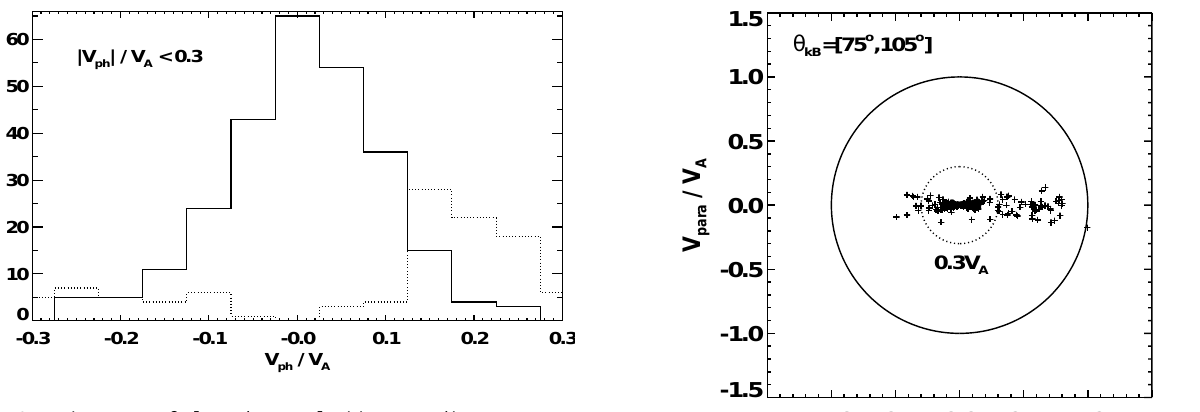
Fig. 9. Histogram of slow phase velocities: standing structures (solid) and slow propagating waves (dotted) in the plasma rest frame.